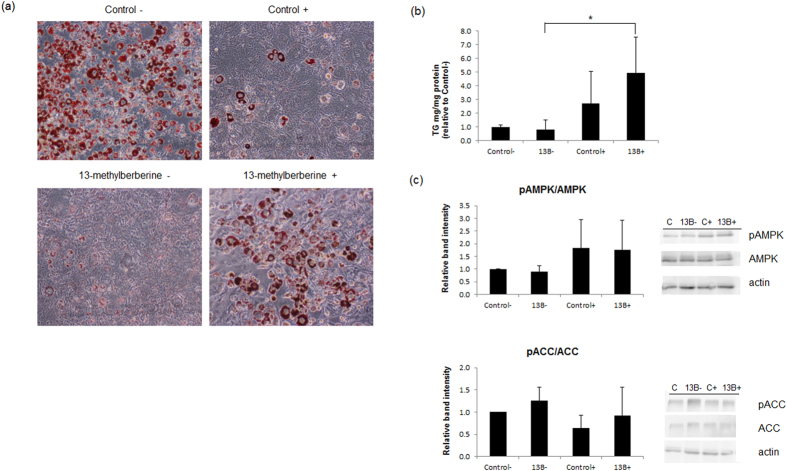
Effects of an AMPK inhibitor (Compound C) on control and 13-methylberberine-treated adipocytes.(a) Oil Red O staining in 3T3-L1 adipocytes on Day 12. n = 5 from 2 independent experiments. Images shown are results of a set of samples from one experiment. (b) Triglyceride content in 3T3-L1 adipocytes on Day 12. n = 6 from 2 independent experiments, error bar = standard deviation, *p < 0.05 two-tailed Student’s t-test. (c) Phosphorylation of AMPK and ACC at 6 h. n = 3 from 3 independent experiments, error bar = standard deviation. −/+ (without or with compound C), 13B–13-methylberberine 5 μM. The results are normalized to the control - (without Compound C).